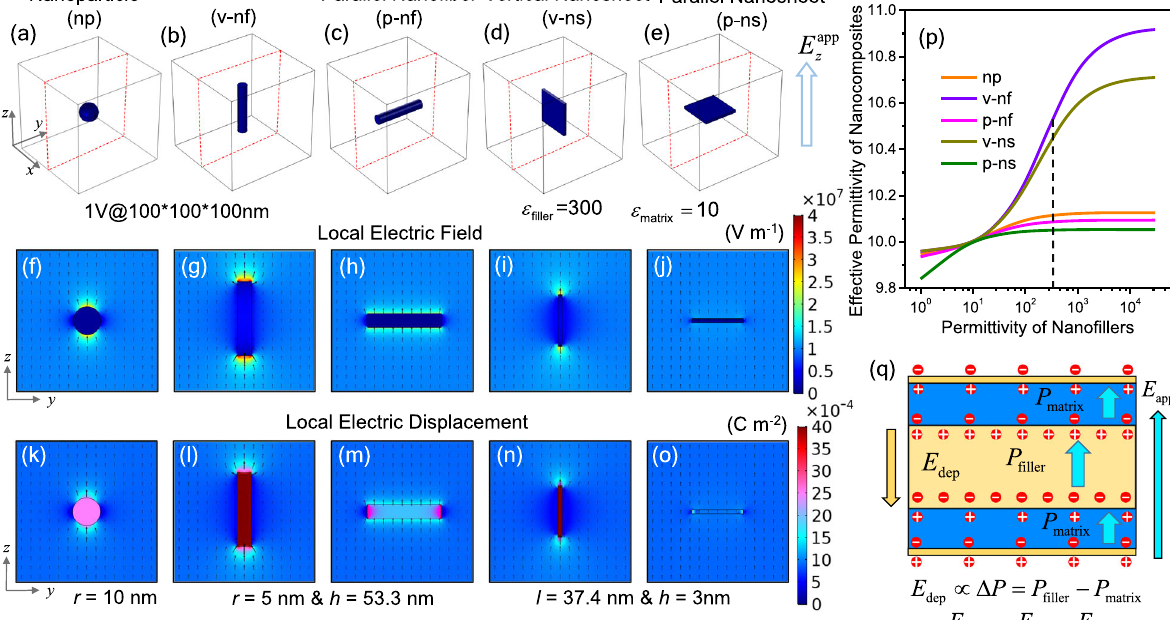
Fig. 1 The nano fi ller effect on the dielectric response of polymer nanocomposites. Three-dimensional microstructural diagrams of polymer nanocomposites (100 nm*100 nm*100 nm) with a one nanoparticle(np), b one vertical nano fi ber(v-nf), c one parallel nano fi ber(p-nf), d one vertical nanosheet(v-ns), and e one parallel nanosheet(p-ns). The applied electric fi eld is along the direction of z axis with 10 MV m − 1 and the volume fraction of nano fi llers in different nanocomposites is set to the same value by adjusting the radius r , length l , or height h of nano fi llers. The corresponding distributions of local electric fi elds ( f – j ) and local electric displacements ( k – o ) along the cross-section as the red dashed line shown. The arrows represent the sum of vectors in the y and z directions. p Calculated effective permittivity as a function of the permittivity of different nano fi llers. q Schematic of depolarization effect using a simpli fi ed parallel laminated composite with an intermediate ceramic interlayer in yellow and two bilateral polymer layers in